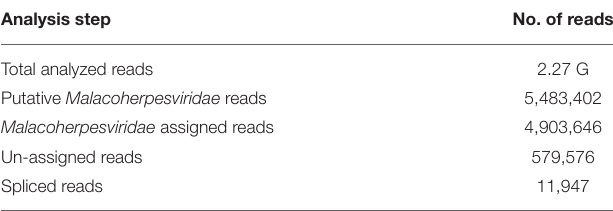
TABLE 4 | Identification of Malacoherpesviridae reads in C. gigas RNA-seq data.